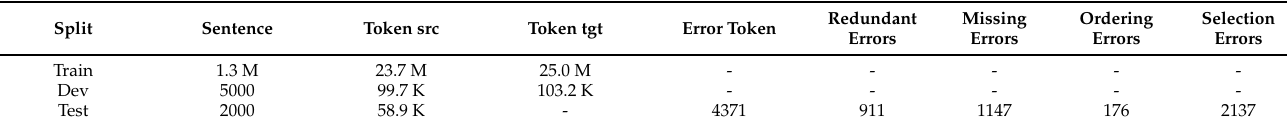
Table 1. Details of NLPCC 2018 test